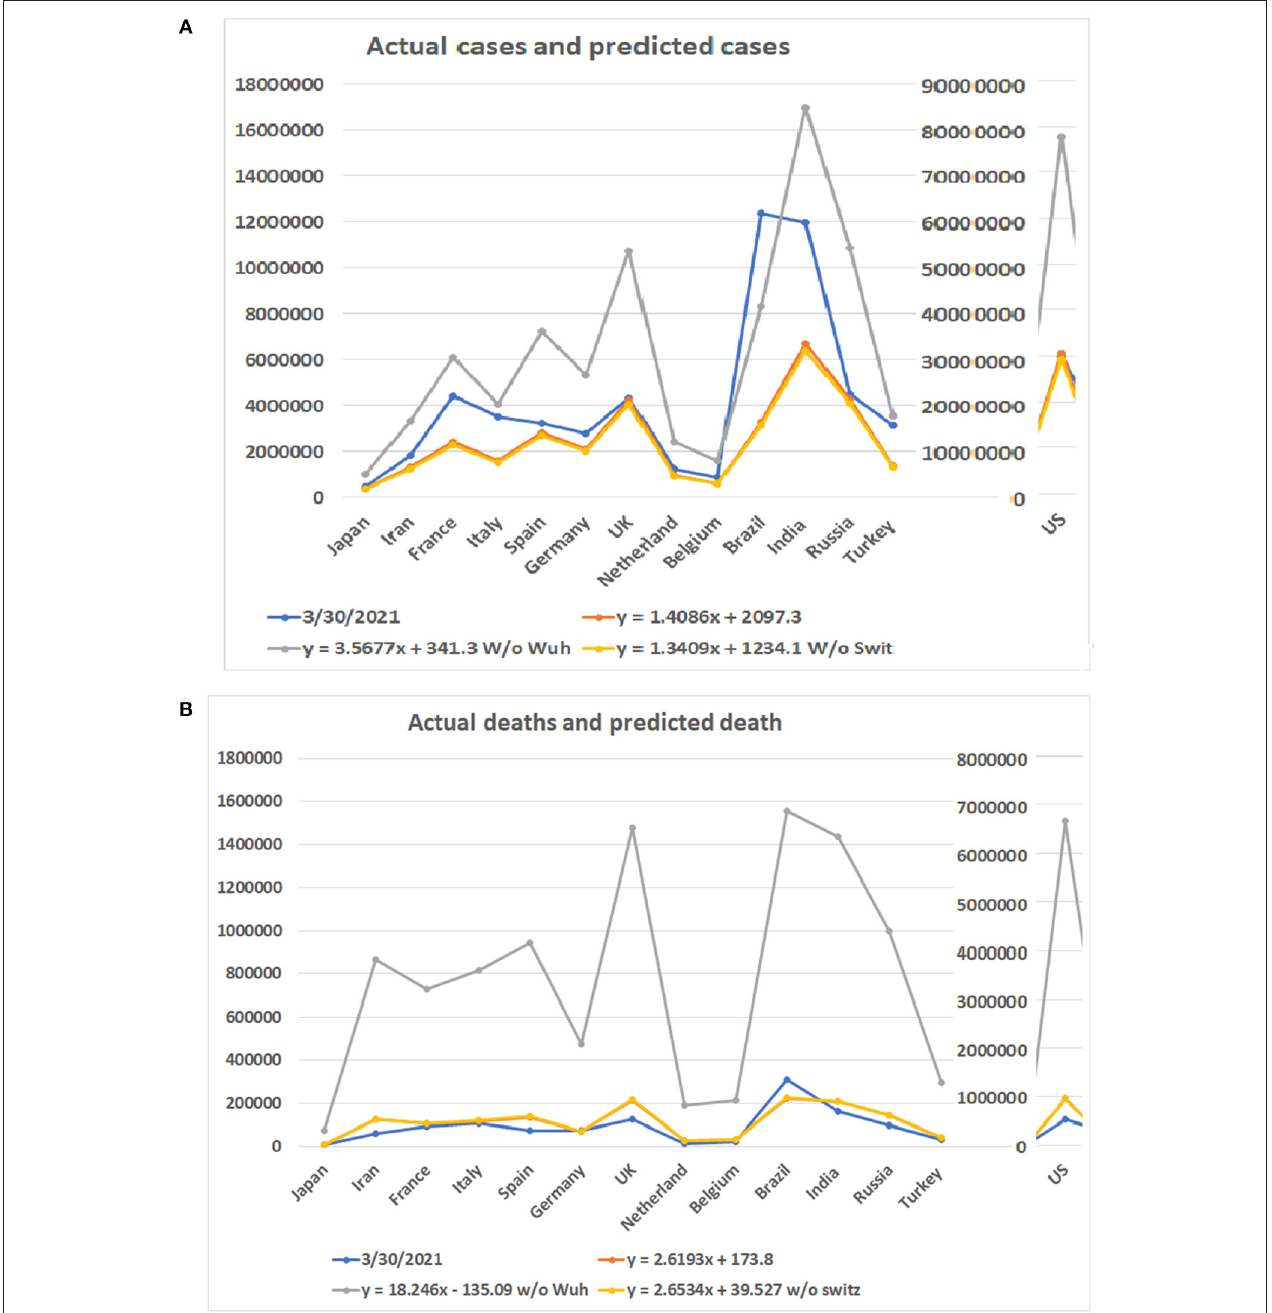
FIGURE 6 | Comparison of predicted numbers of patients and deaths on March 30, 2021 to the real numbers. Numbers on Y bar are the case of death numbers. Color code: Blue for the real numbers up to March 30, 2021. Red for the predicted numbers based on linear model. Gray color for the predicted numbers based on the linear model without data from Wuhan. Point for predicted numbers without data from Switzerland. (A) Predicted number of cases based on three linear models and real number of cases. (B) Predicted number of deaths based on three linear models and real number of deaths. after the apex day are 3.87 and 11.58 times more than that infected patient data, these models included linear, polynomial, before the apex day, with and without the data from Wuhan, and exponential regressions (see Supplementary Figure 3 ). The models in Figure 3B included the data from Wuhan while those respectively. Accordingly, the three types of regression models in Figure 3C did not. The models in Figure 3D shows the were performed between the death number before apex day relationship without the data from Switzerland. These and the total death numbers (see Figures 3B,C ). Similar to the